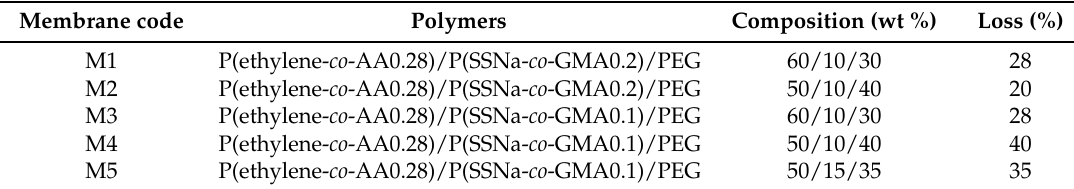
Table 1. Composition of blends and water loss of P(ethylene- co -AA0.28)/P(SSNa- co -GMA0.1 or 0.2)/PEG.